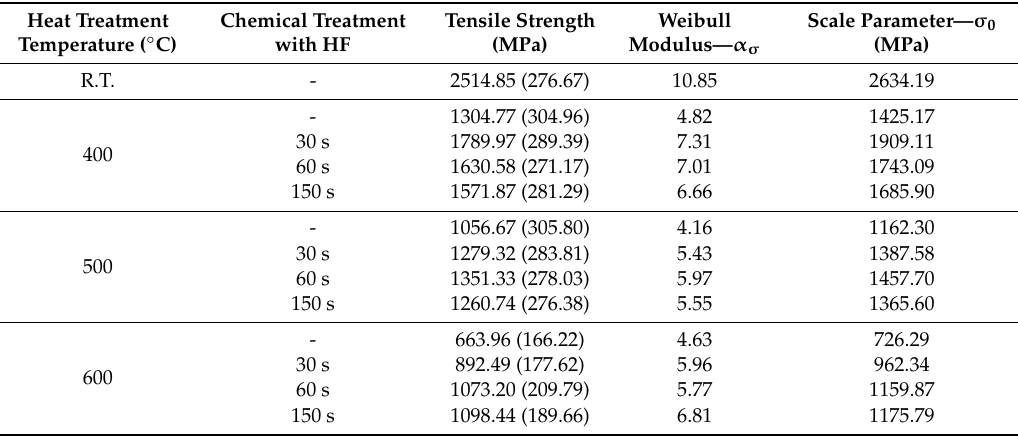
Table 2. Average tensile strength for regenerated basalt fibres after HF treatment and Weibull parameters of the strength distribution (standard deviation in